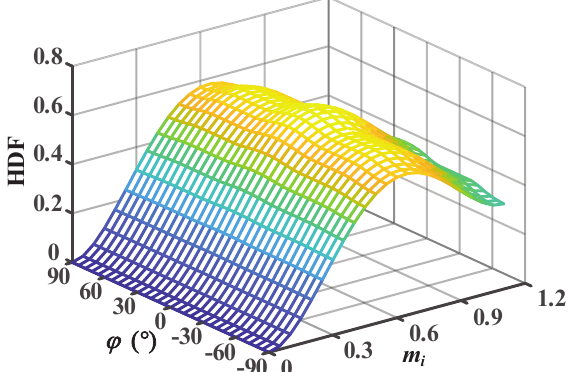
Figure 6. The harmonic distortion factor, HDF, characteristic of the MSL-DPWM at k f =